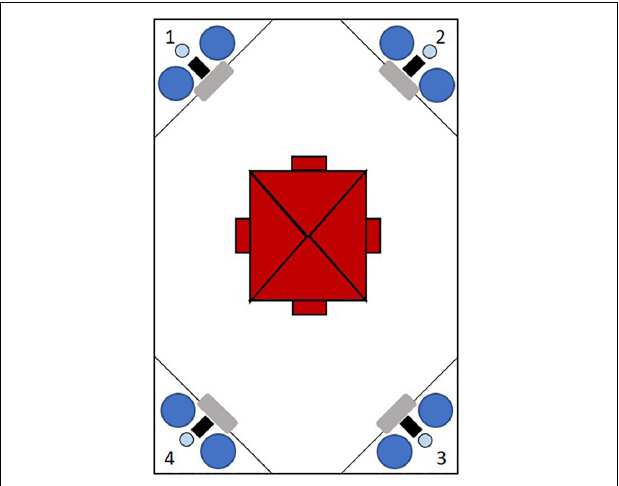
FIGURE 1 | Schematic figure of an IntelliCage from the top with four conditional corners marked by numbers. Each corner contains a radio frequency identification antenna (gray), a presence-sensor (black), an airpuff valve (light blue) and two water dispensers (dark blue). In the cage center four shelters (red) are arranged under the food rack.